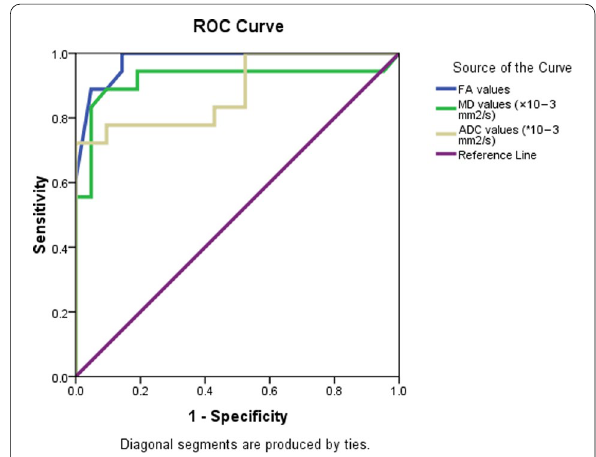
Fig. 3 ROC curve of FA, MD, ADC in differentiating grade 2 from grade 1 and 3 endometrial